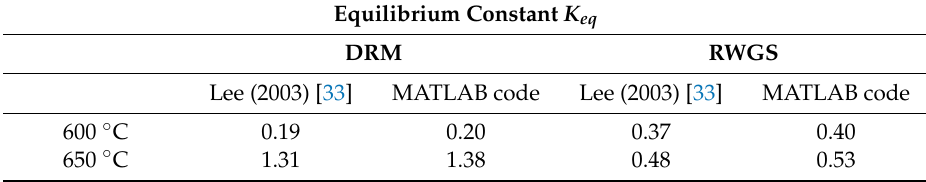
Figure 3. CH 4 conversion at equilibrium: ( Left side) as a function of pressure, CO 2 /CH 4 feed molar ratio of 1, temperature of 650 °C ( ● ) and 600 °C ( ♦ ), compared with experimental data (Lee (2003) [33]); ( right side) as a function of temperature, CO 2 /CH 4 feed molar ratio of 1.5, pressure of 1 bar ( ▲ ), compared with experimental data (Chein et al. (2015) [34]). Table 3. Equilibrium constant for dry reforming of methane (DRM) and reverse water gas shift (RWGS) reactions calculated at a temperature of 600 °C and 650 °C and compared with experimental data of Lee (2003) [33].